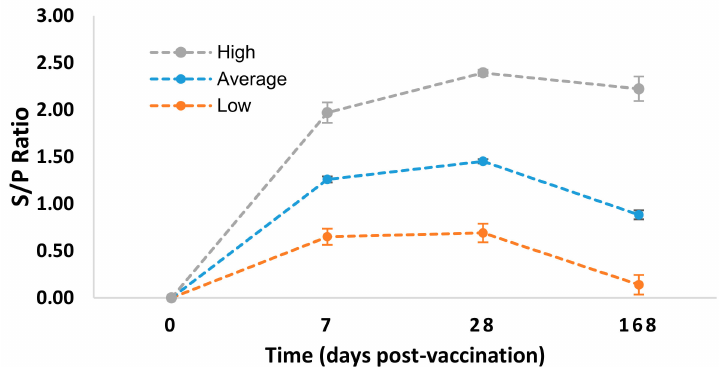
Figure 1. Sample to positive (S / P) ratio of cattle groups identified as high ( n = 5), low ( n = 5) and average ( n = 107) bovine viral diarrhea virus (BVDV) type I antibody level at di ff erent time points. The error bars indicate standard